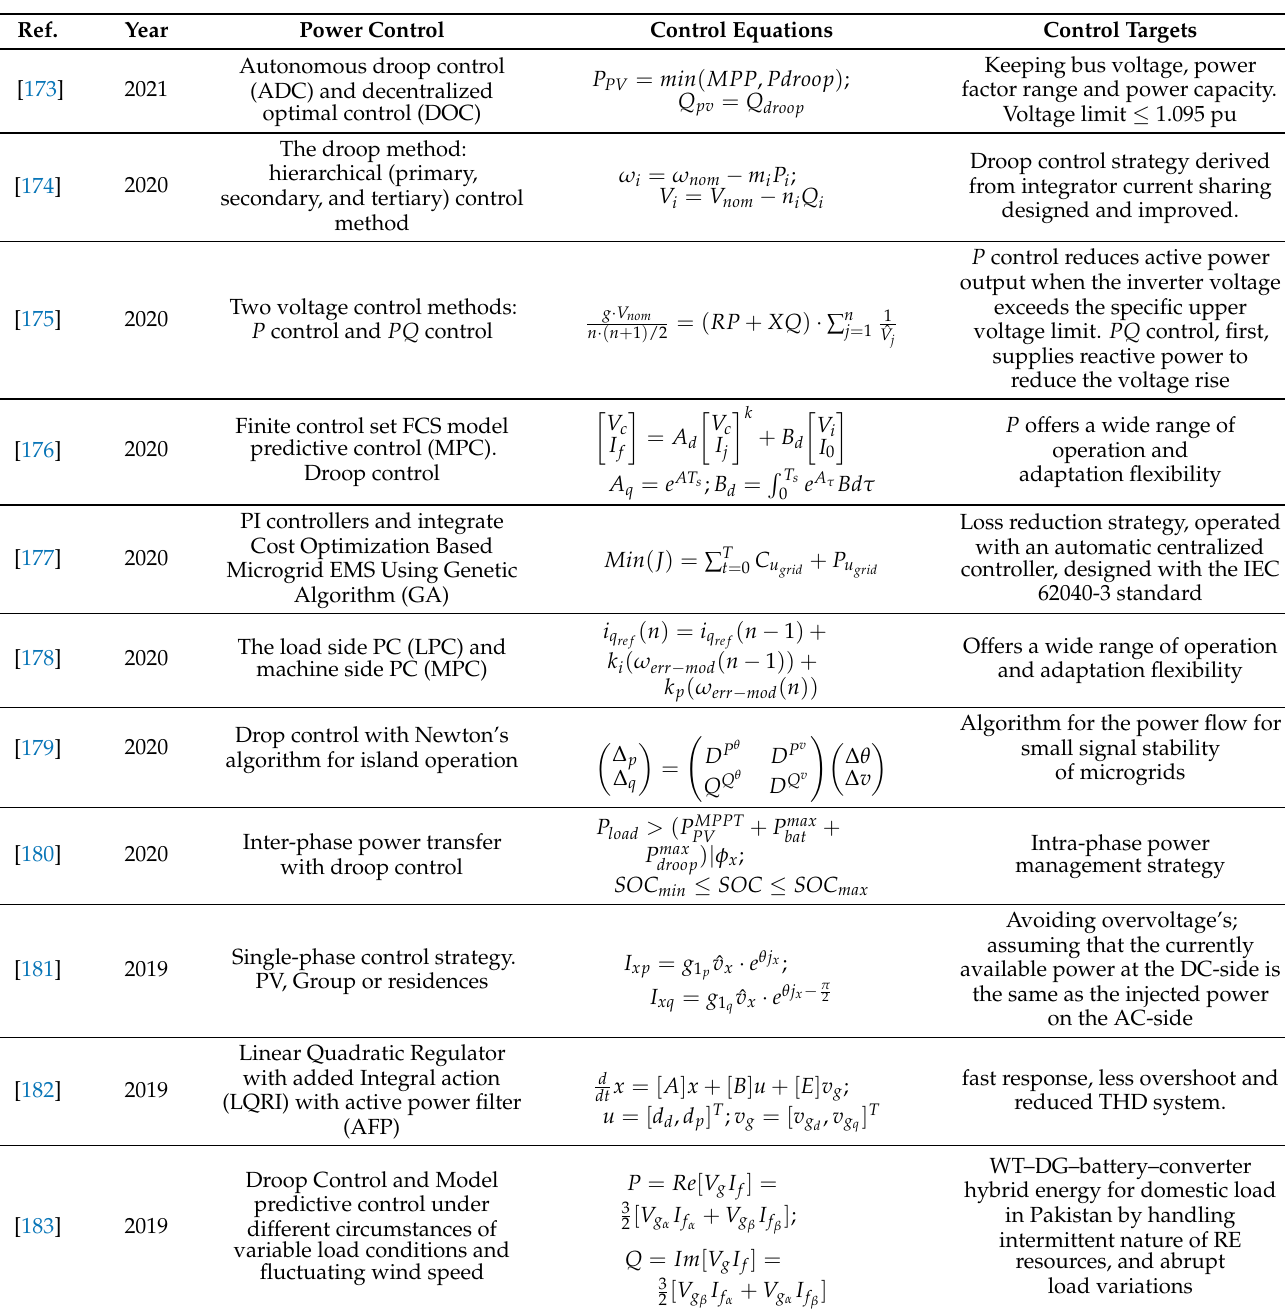
Table 7. Inverter control approaches (I).